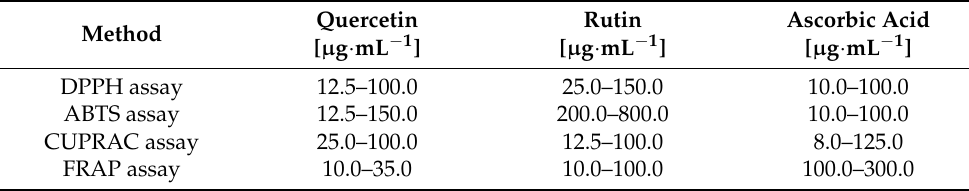
Table 1. Ranges of quercetin, rutin, and ascorbic acid concentrations used in studies of antioxidant